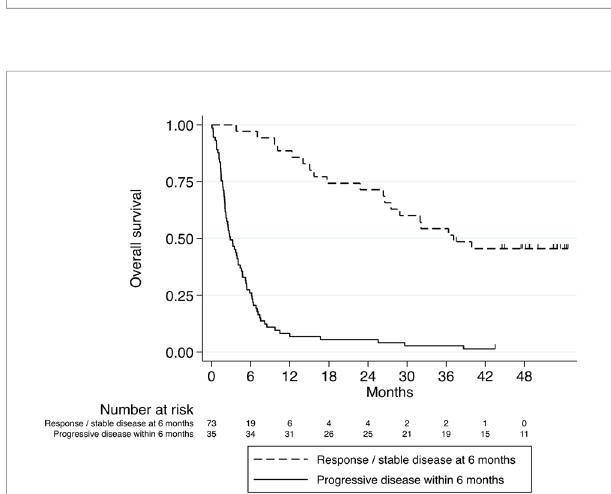
FIGURE 1 | Kaplan – Meier curve for overall survival (entire study cohort, n=108). Median OS 5.4 months (95% CI 3.9-7.4).